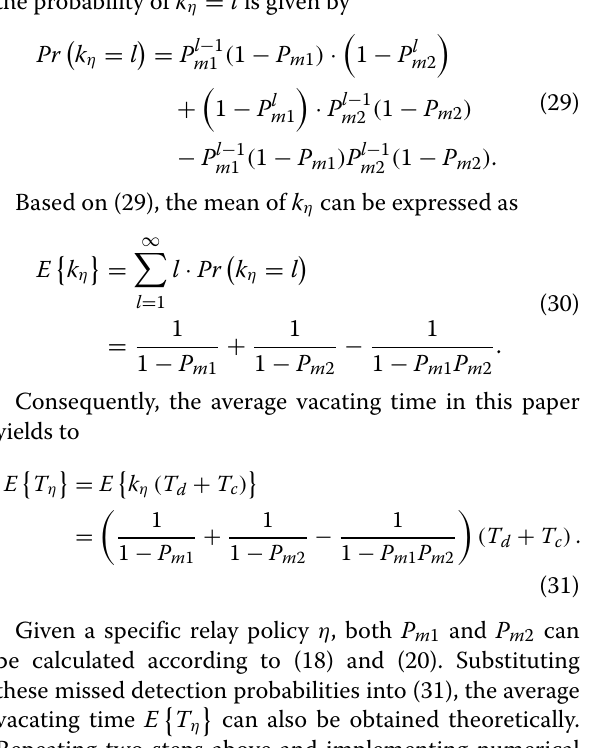
versus relay policy η for different SNRs of SU 2 ( γ 2 =